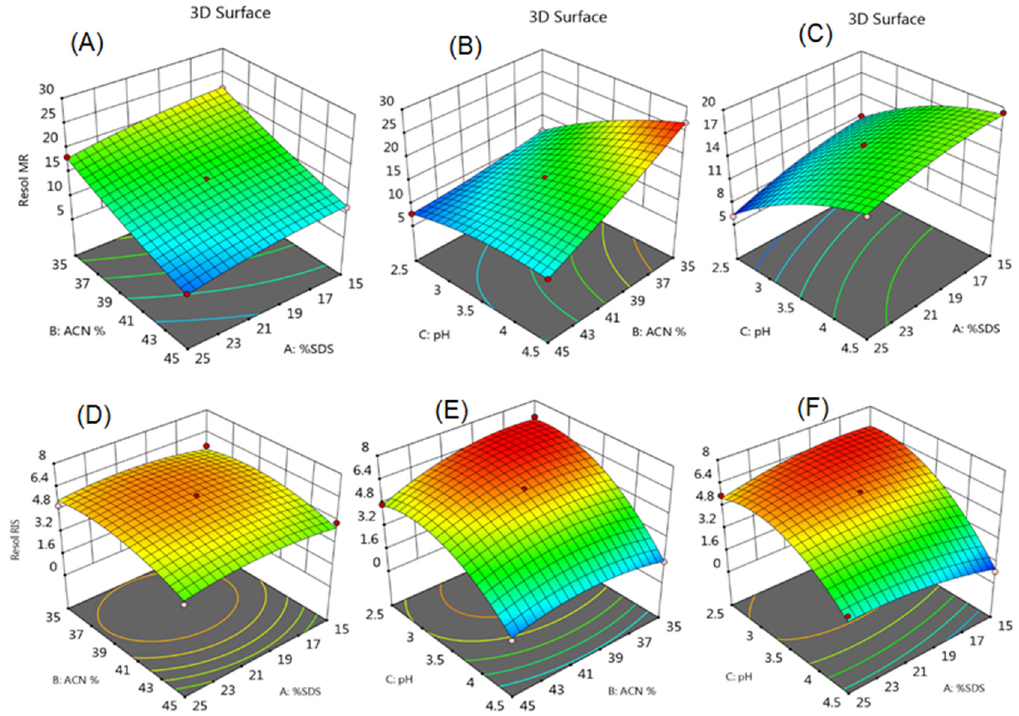
Figure 6. Response surface models showing the effect of percent of SDS, percent of acetonitrile and pH of the mobile phase on the resolution of MFH to RGE ( A – C ) and RGE to IS ( D – F ).